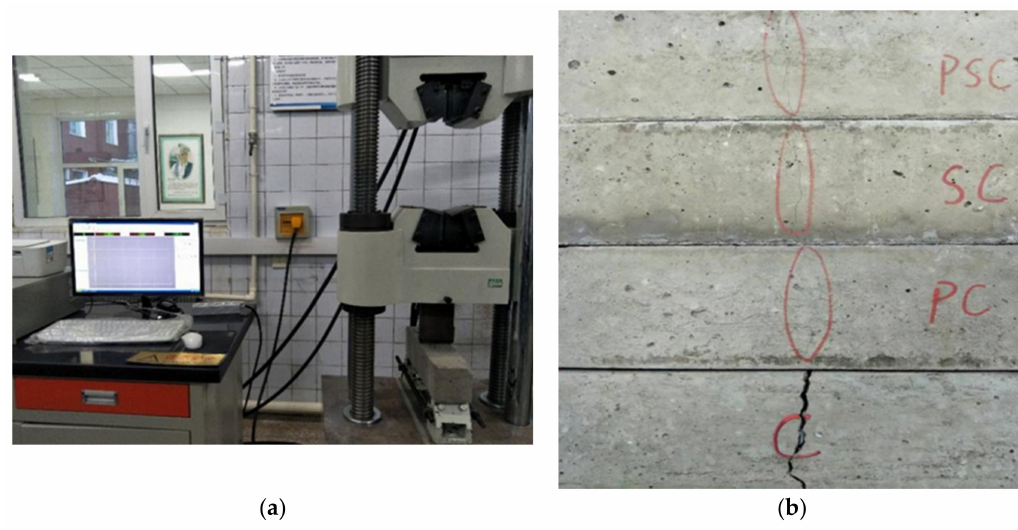
Figure 6. Electro–hydraulic servo universal testing machine and the damaged specimens after the four-point bending test. ( a ) Electro–hydraulic servo universal testing machine; ( b ) damaged specimens after four-point bending